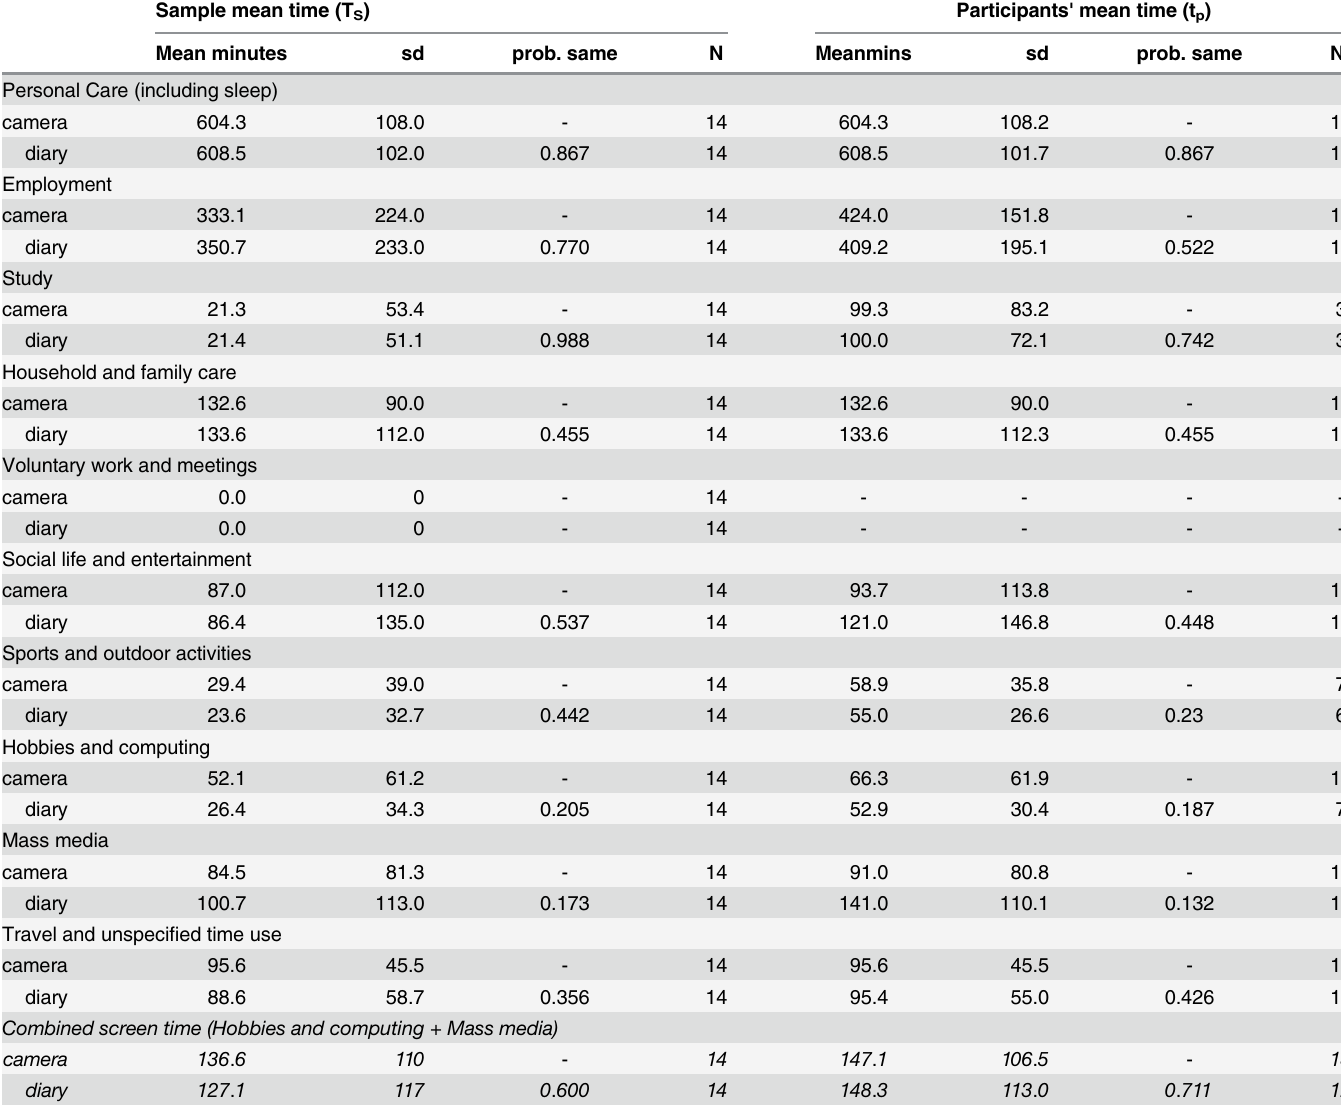
Table 2. Comparison of minutes assigned to HETUS 1 digit activities by camera and diary day (Levene's Test for Equality of Variances: no signifi- cant differences). Sample mean time (T S